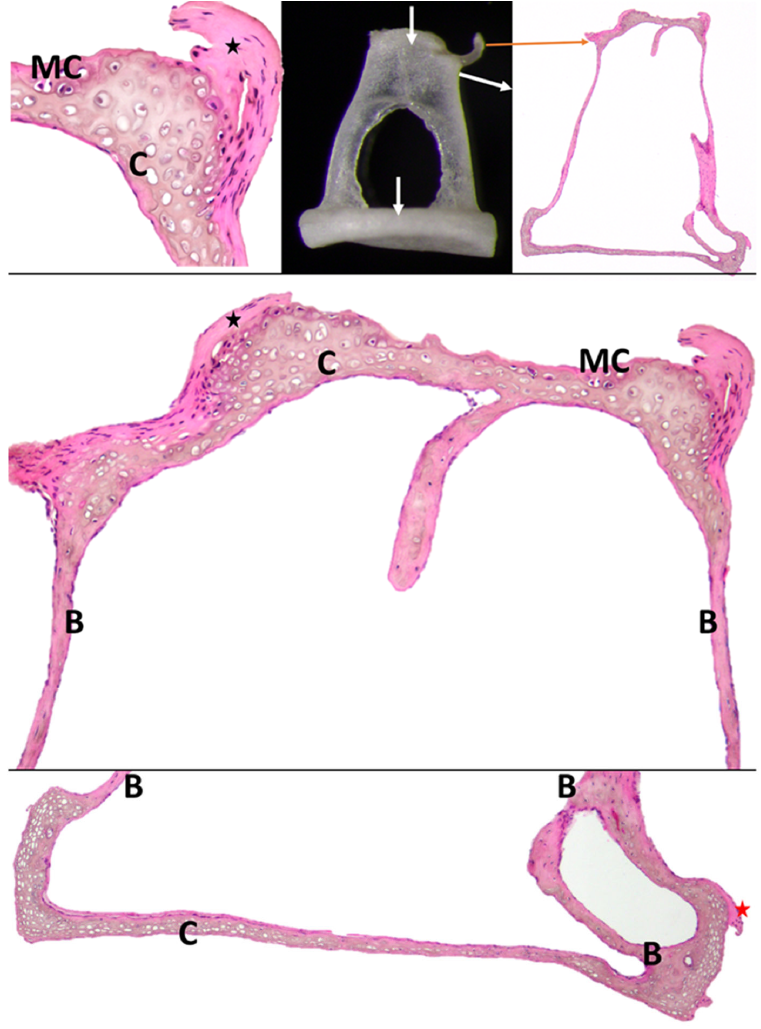
Figure 6. Histological aspects of the stapes. B—compact bone; C—articular hyaline cartilage; MC—mineralized cartilage; orange arrow—m. stapedius; black star—incudostapedial joint ligament; red star—annular ligament ( Ligamentum anularis stapedis ).